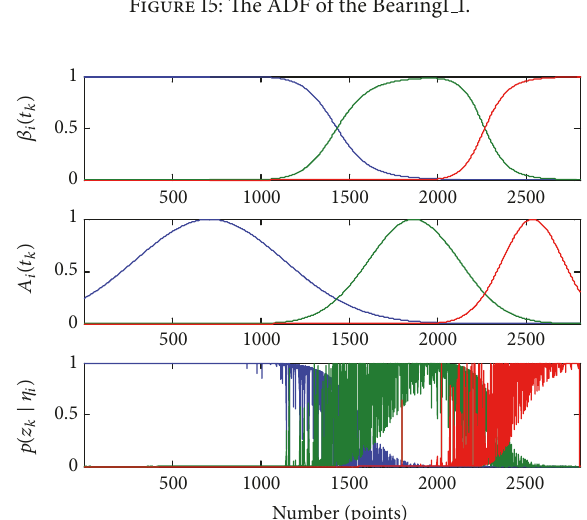
Figure 16: The result of Bearing1 1’s ADF based on GGCTSS.